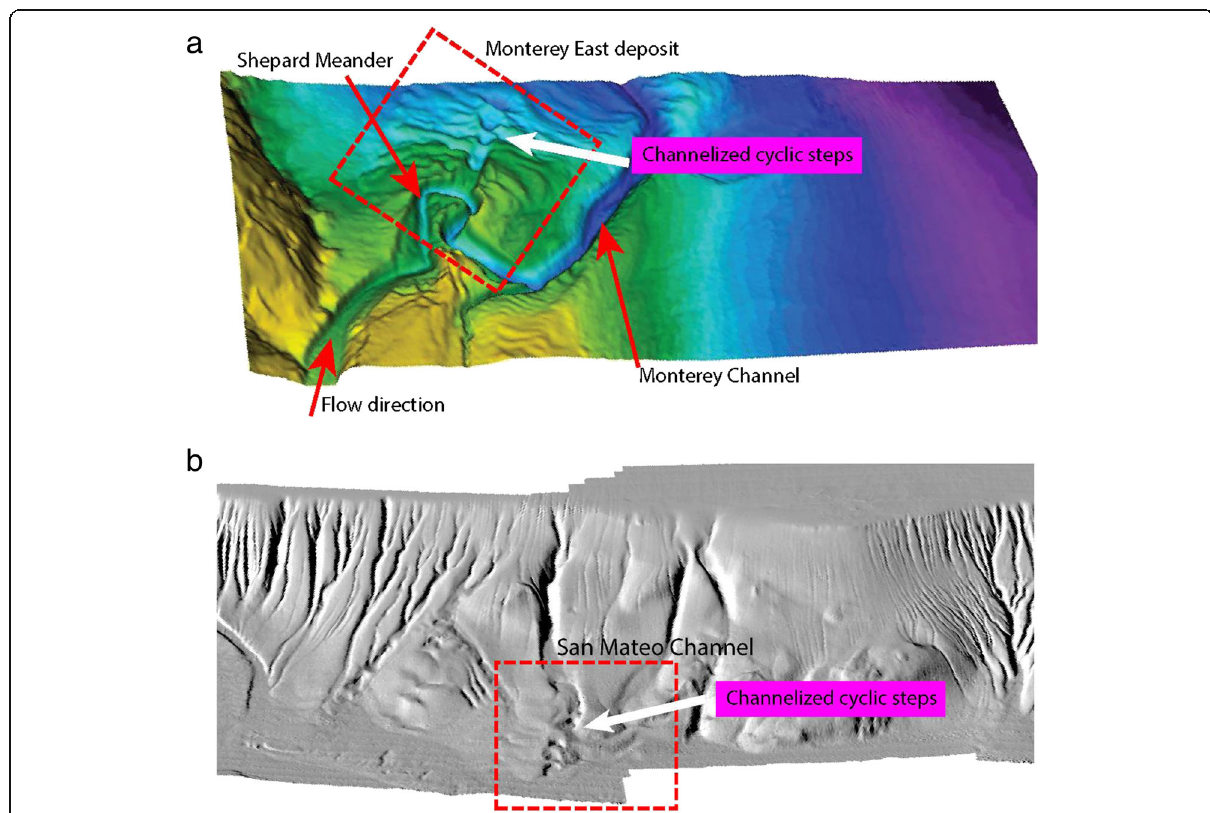
Fig. 5 Cyclic steps in submarine channels on Earth as analogs for bedforms on Martian deltas. a Large-scale net-depositional cyclic steps on the outer levee of the Shepard Meander dissected by a linear train of net-erosional cyclic steps in the Monterey East Channel, California, USA (image courtesy A. Fildani; high vertical exaggeration is to enhance bedforms); b A series of cyclic steps along the thalweg of the San Mateo Channel, California, USA (modified from Covault et al.